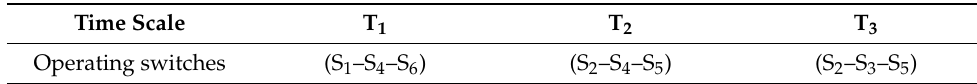
Table 2. Changing states at various periods of